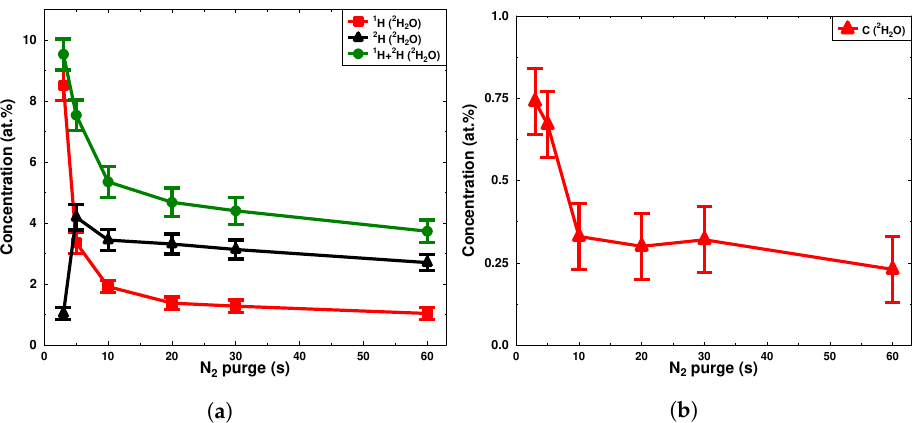
Figure 6. ( a ) Hydrogen and ( b ) carbon concentration as a function of the N 2 purge time. All the samples were deposited at 60 ◦ C using 150 ms DEZ pulses and 500 ms 2 H 2 O pulses. The purging time between the pulses was varied. The purging times after both precursors were kept the same when the purging time was 3, 5 or 10 s. For longer purging times, only the purge after 2 H 2 O was increased, and the purge after DEZ was kept at 10